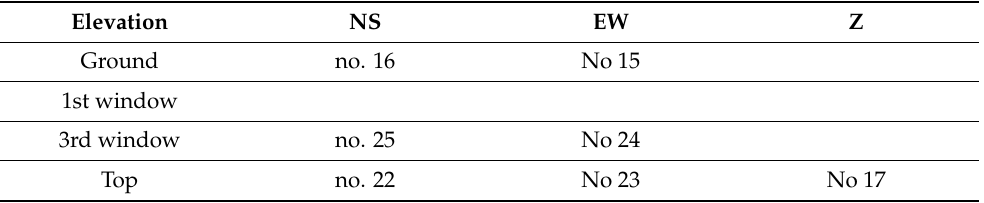
Table 3. Location and orientation of